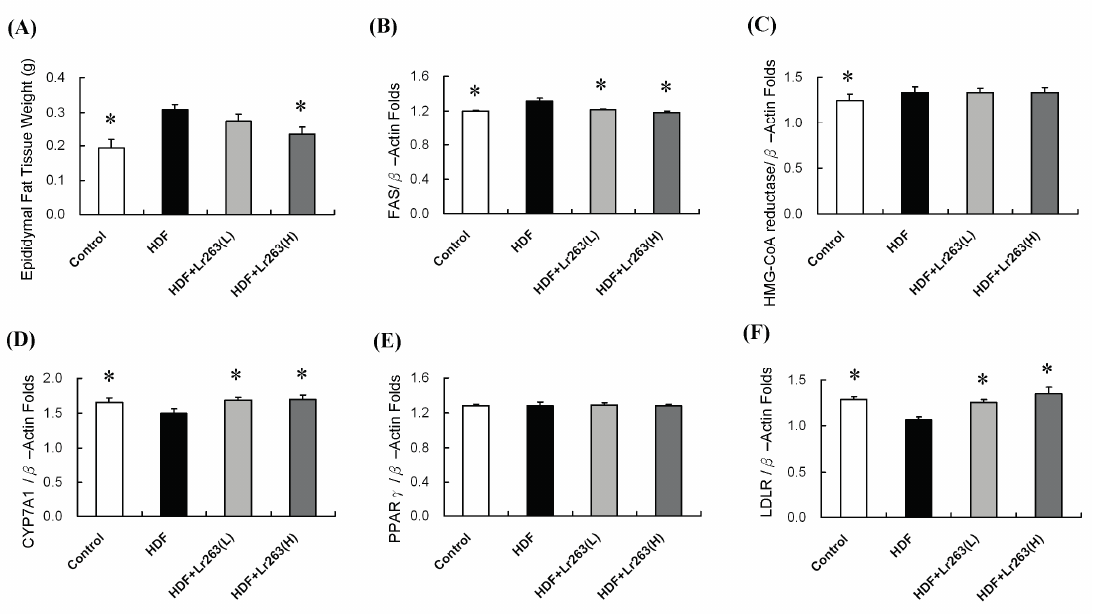
Figure 1. The animal epididymal adipose tissue weight and liver lipid and cholesterol metabolism biomarkers. ( A ) The HFD hamster epididymal adipose tissue weights were higher than in the control group, and the apididymal adipose tissue weight was lower in the heat-killed Lr263 (625 and 3125 mg/kg-hamster/day) treatment groups; ( B ) FAS; ( C ) HMG-CoA reductase; ( D ) CYP7A1; ( E ) PPAR γ ; and ( F ) LDLR are liver lipid metabolism biomarkers and were analyzed using RT-PCR. FAS and HMG-CoA reductase were greater in the HFD group and lower in the heat killed Lr263 (3125 mg/kg-hamster/day) treatment groups, but the difference in HMG-CoA reductase was not significant in the heat-killed Lr263 treatment groups. LDLR and CYP7A1 was lower in the HFD group and greater in the heat killed Lr263 (625 and 3125 mg/kg-hamster/day) treatment groups. (* p < 0.05 compared with the HFD